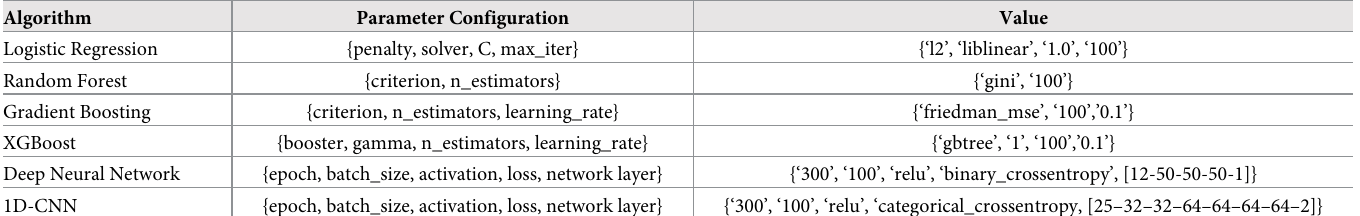
Table 4. Hyperparameter tuning of machine learning